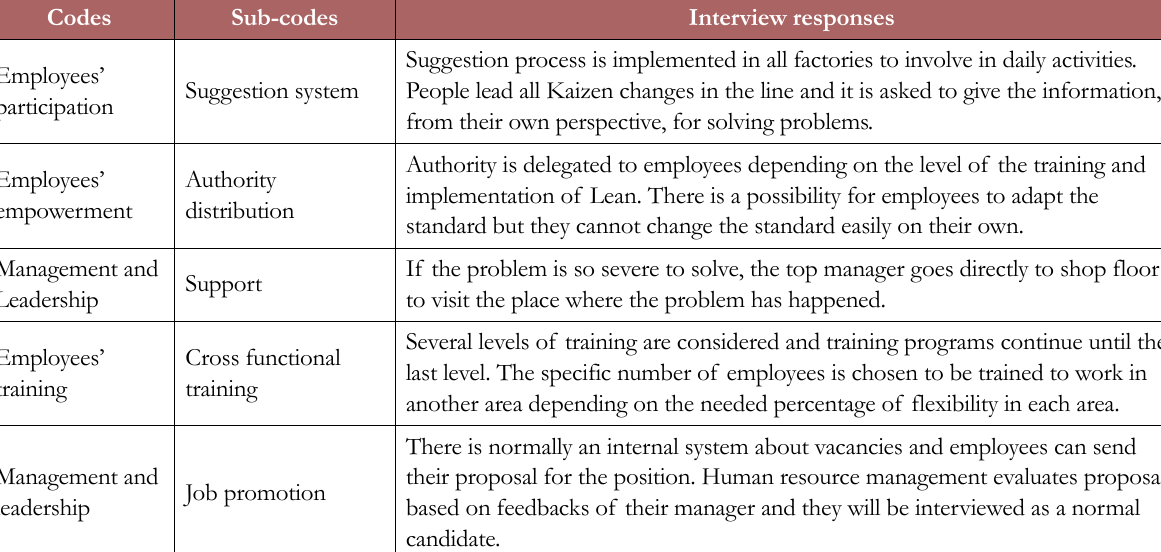
Table 1. Quotes of interviews related to dimension